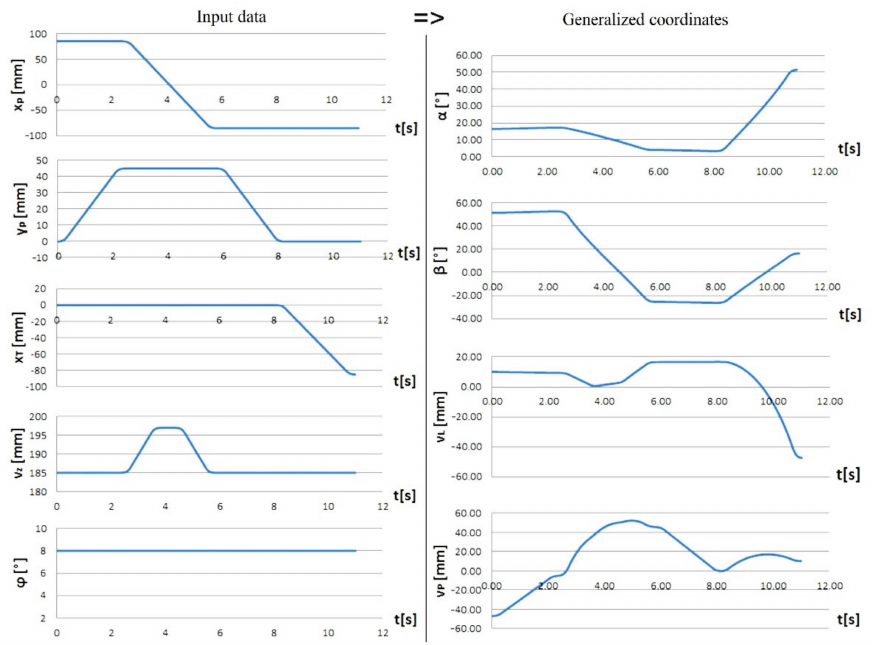
Figure 19. Recalculation of generalized coordinates based on input data for slope 8 ◦ .